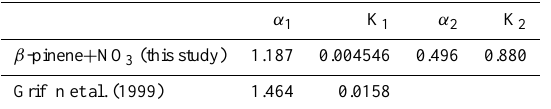
Table 2. Fit parameters for two-product model proposed by Odum et al. (1996). α 1 K 1 α 2 K 2